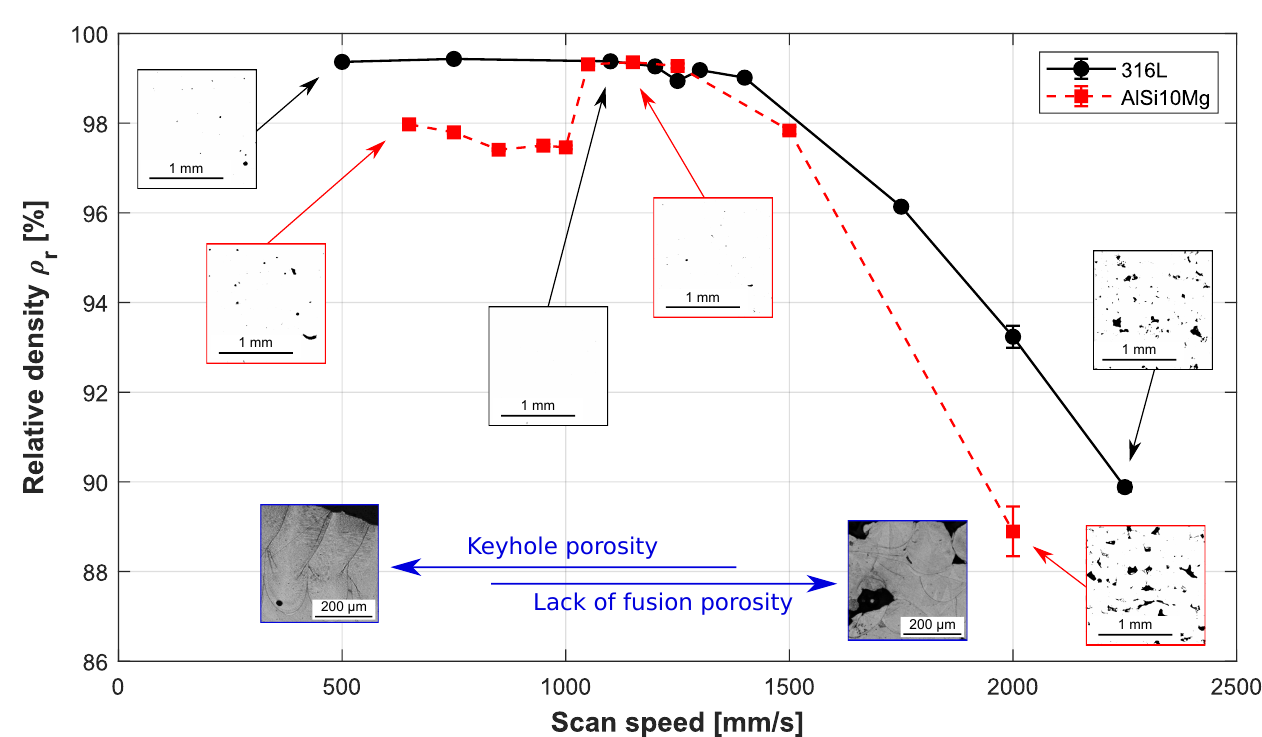
Figure 3. Relative part density of parts manufactured from AlSi10Mg and 316L powder using varied scan speeds. The error bars depict the standard deviations of three density measurements per part. The micrograph and melt pool images were taken from x-z cross sections of cubes (10 × 10 × 10 mm 3 ) manufactured in close proximity to the parts on the build plate, using the same process